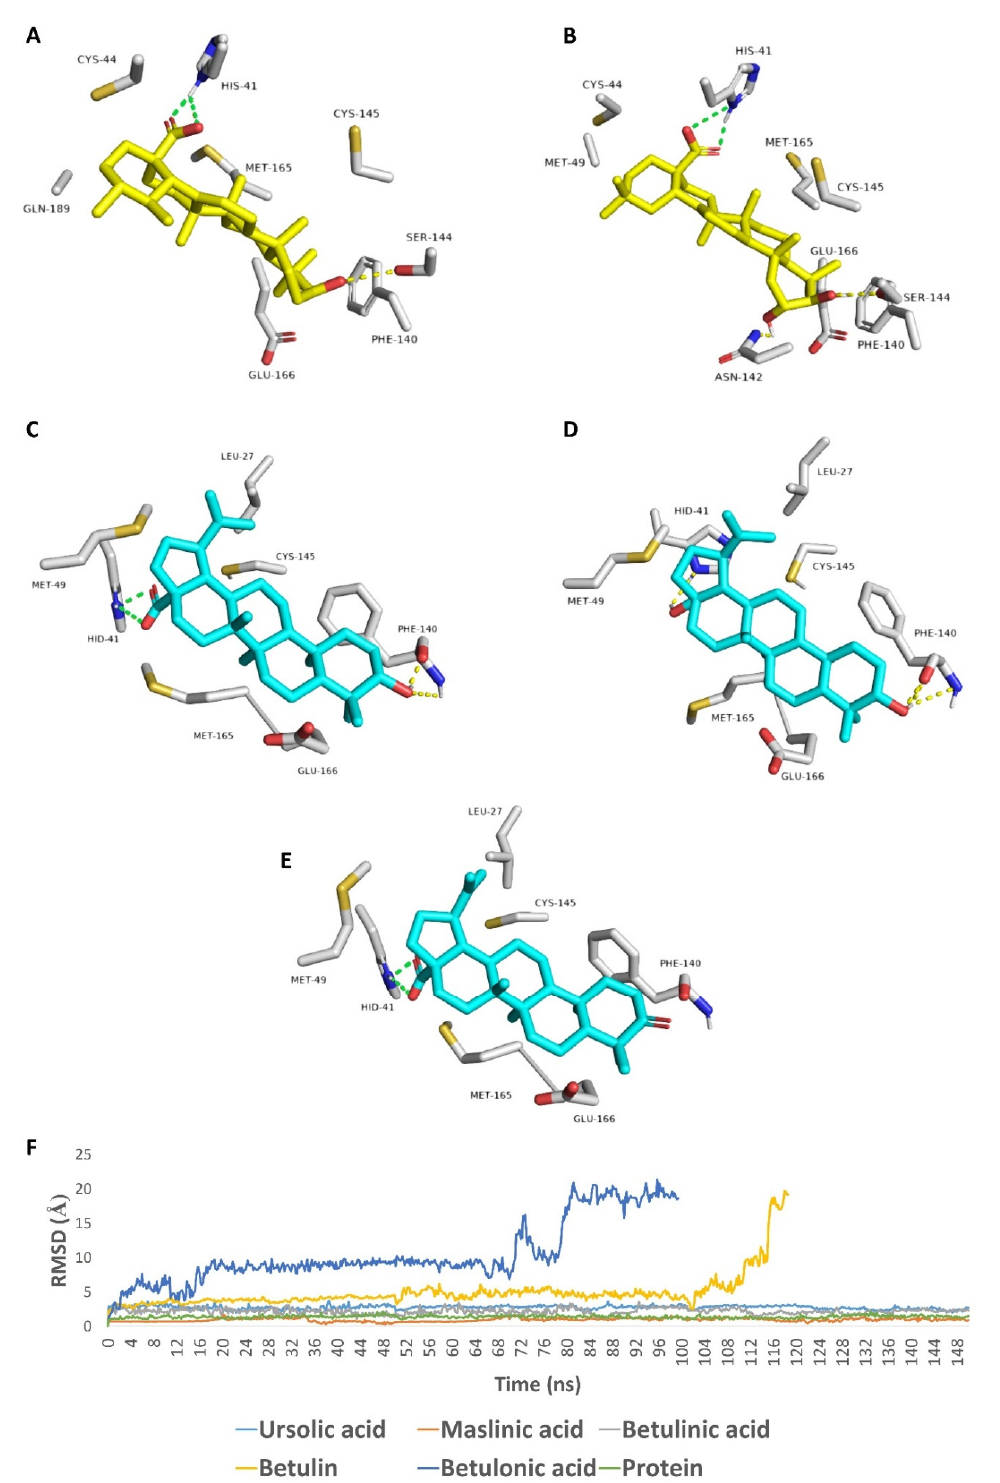
Figure 4. Binding modes of ursolic, maslinic, betulinic acids, betulin, and betulonic acid inside the M pro active site ( A – E , respectively). RMSDs of these compounds along with the apoprotein over 150 ns MDS ( F ).